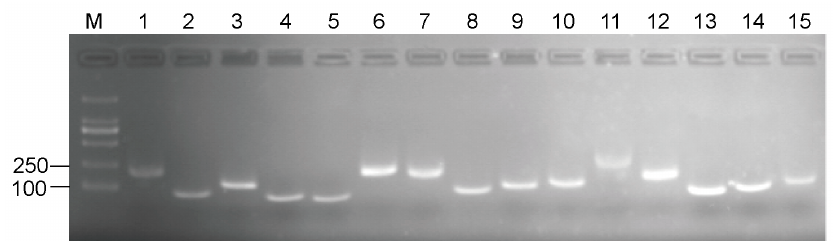
Figure 1. Specificity of primer pairs of all candidate reference genes for qPCR amplification. Here, M represents the DNA size marker. Lanes 1–15 are as follows: TBP , UBCE , NCBP2 , eIF , APT1 , RPL5 , GAPDH , EF-1 α , F-box , TIP41 , PEPC , PP2A , MDH , PTBP3 , and CYP71.